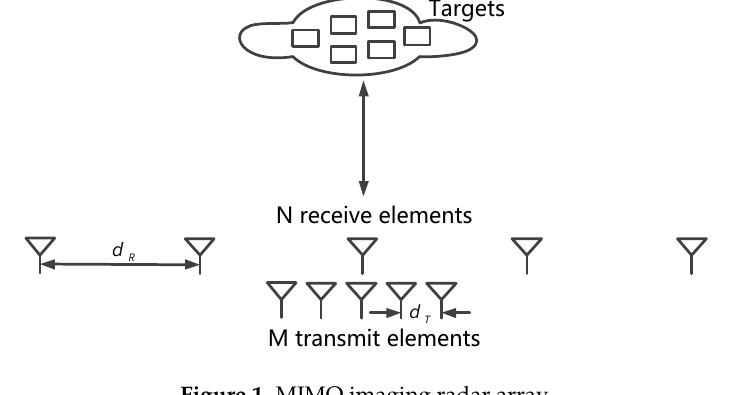
Figure 1. MIMO imaging radar array.